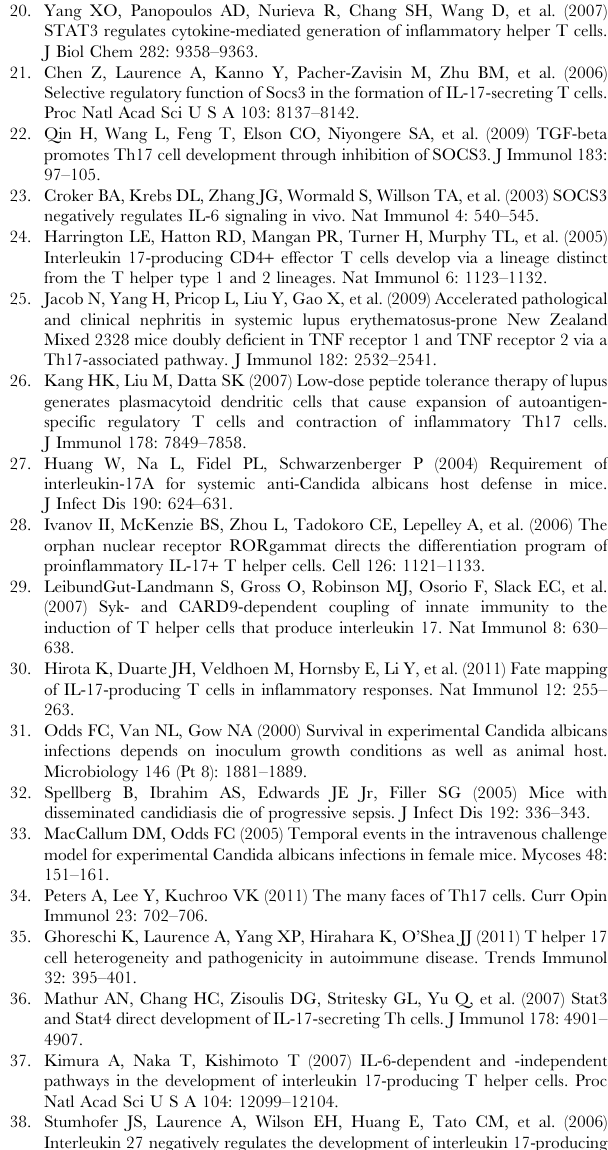
Figure S1 Suppressive ODN do not alter Th1 or Th2 maturation under Th17 polarizing conditions.